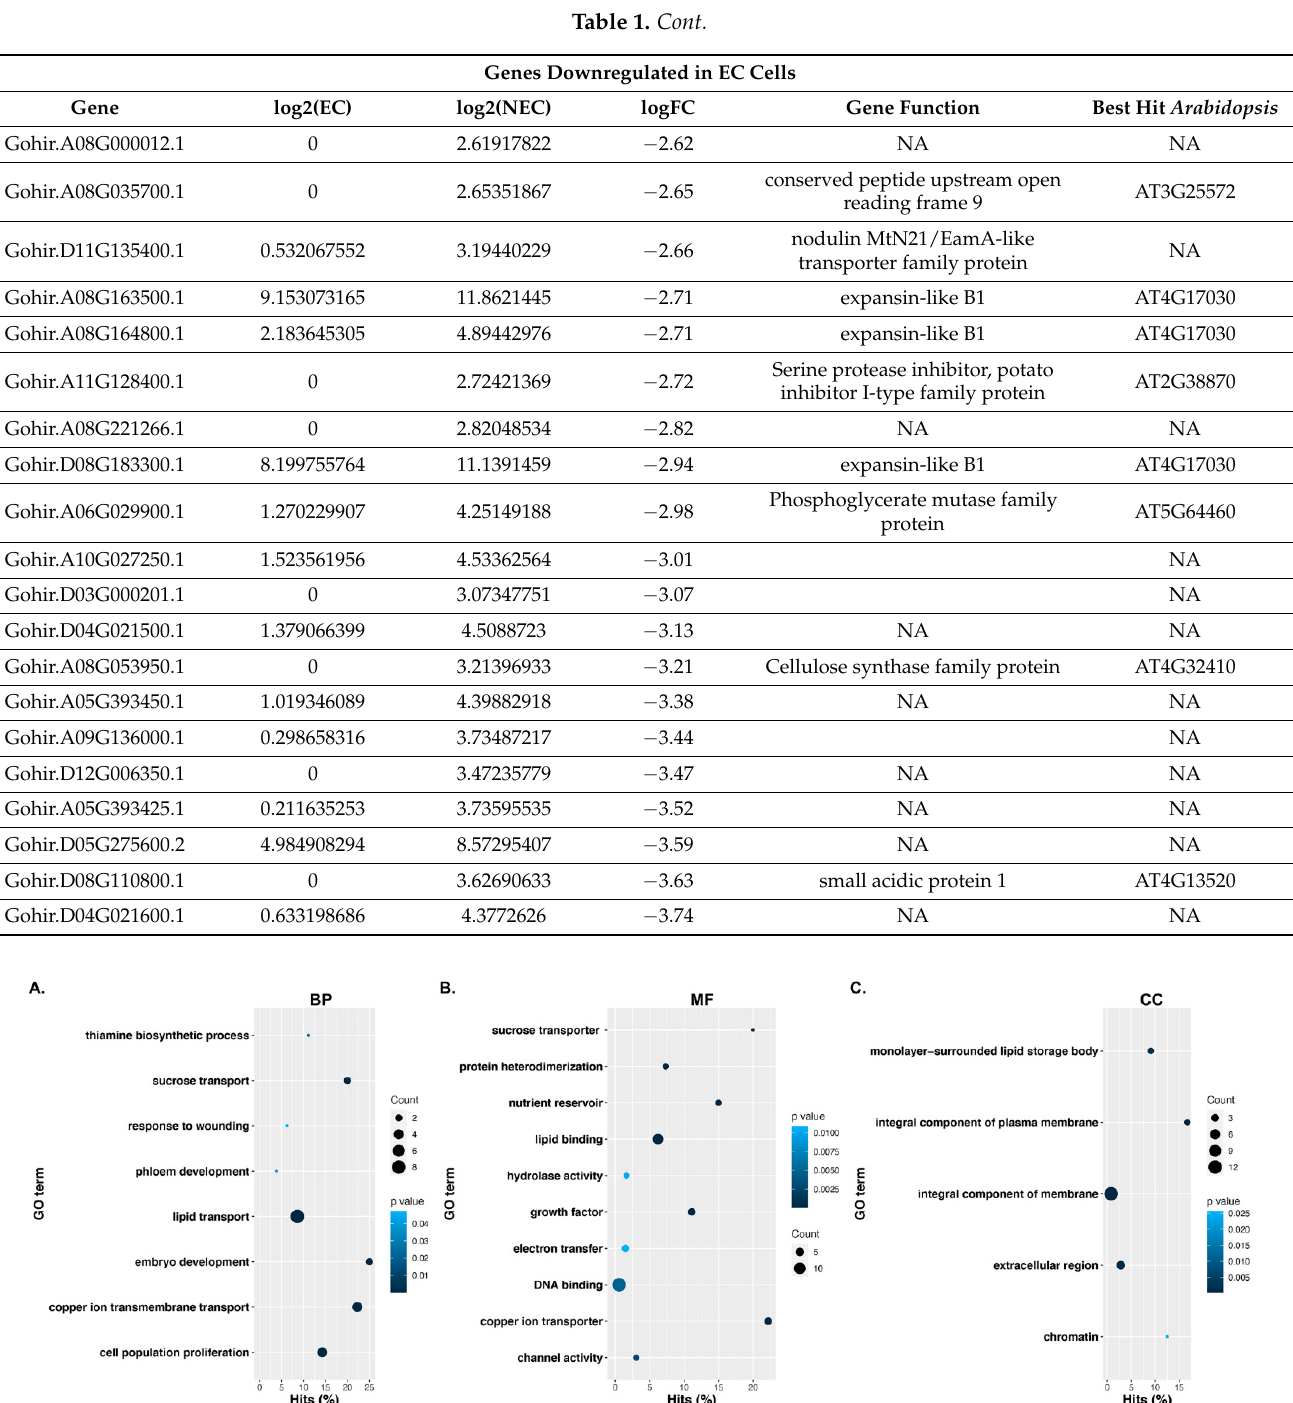
Figure 1. Functional enrichment of the upregulated genes in Coker312 EC cells ( A ) in the biological process (BP), ( B ) in the molecular functions, and ( C ) in the cellular components.